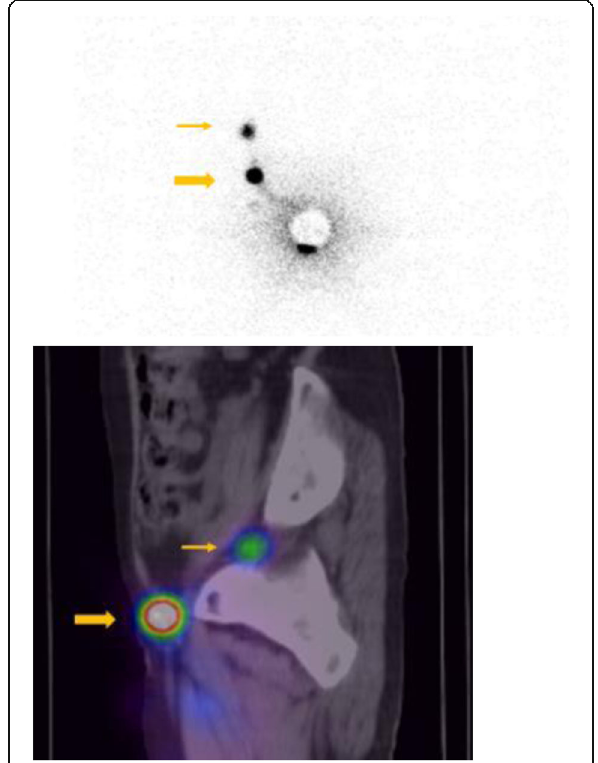
Fig. 3 Lymphoscintigraphy showed hot areas at the right inguinal lymph node ( thick arrow ) and right obturator lymph node ( thin arrow